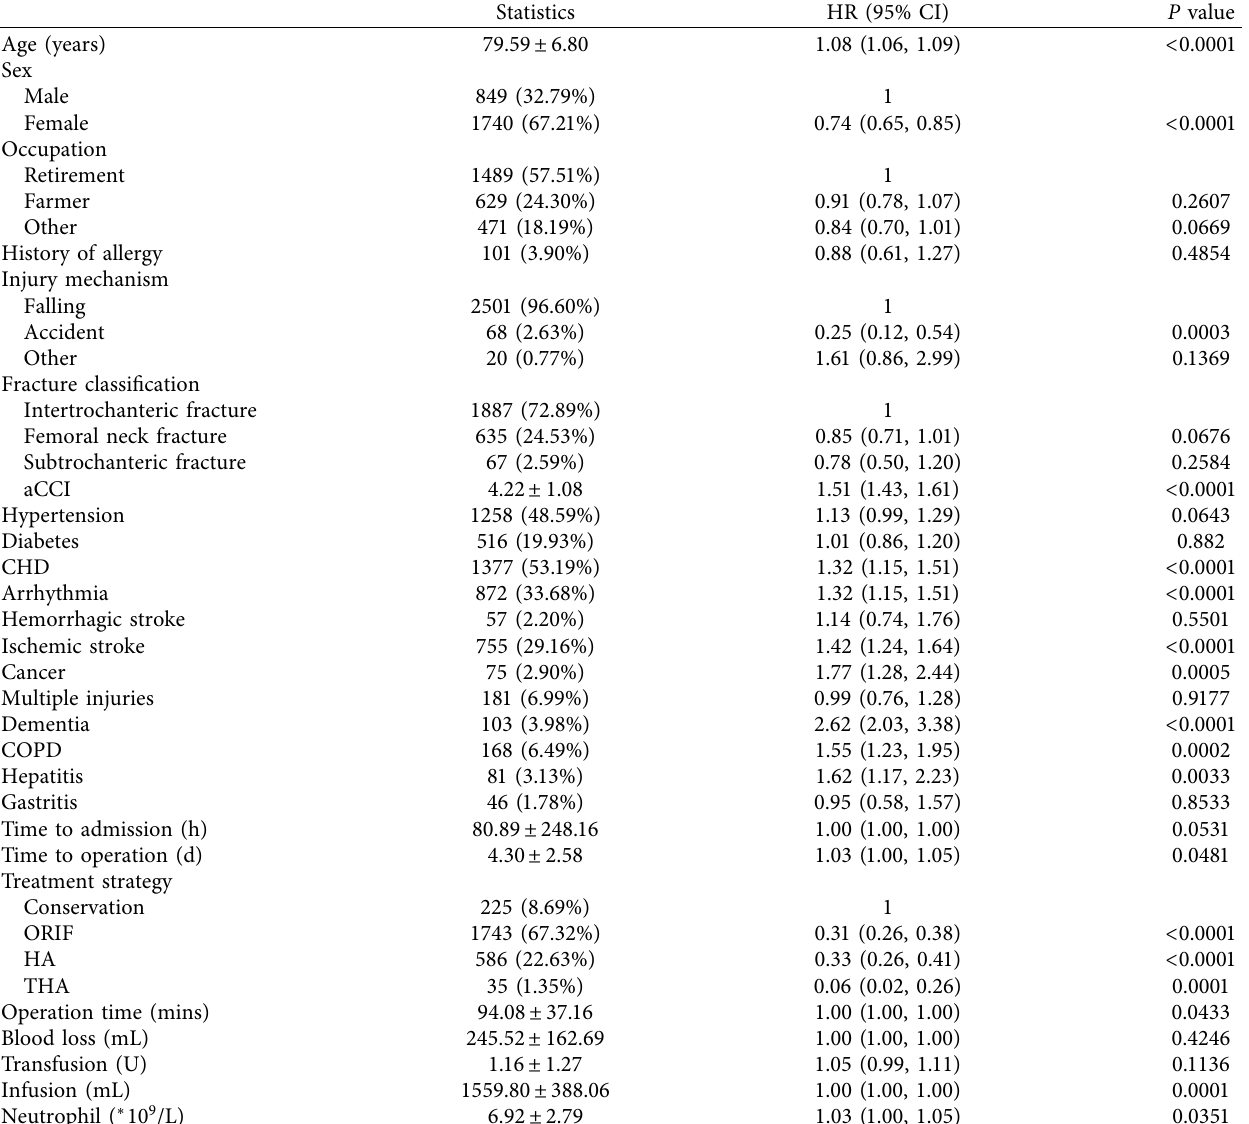
Table 2: Efects of factors on mortality measured by univariate analysis ( N � 2589).